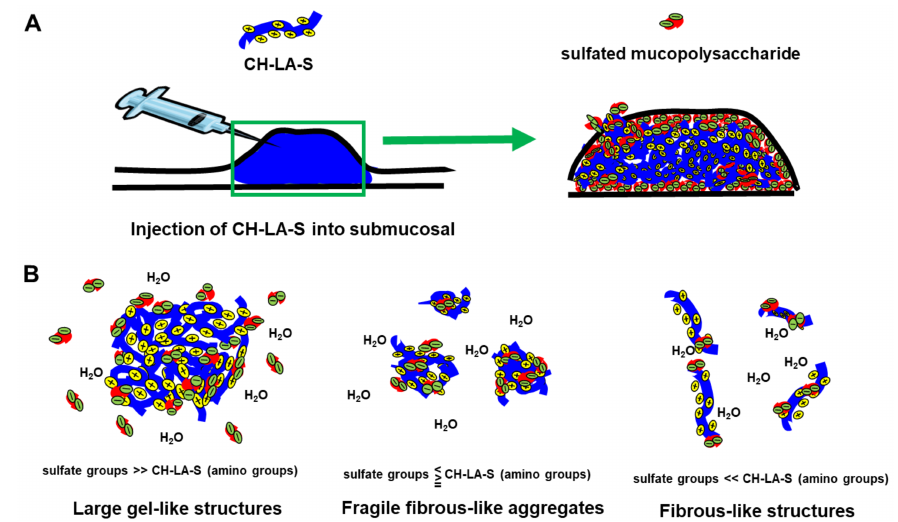
Figure 7. ( A ): Scheme of when CH-LA-S is injected into submucosa. CH-LA-S is adhered to parts in contact with tissues, but the inside of the injected CH-LA-S remains fluid. ( B ): Scheme of different formation patterns due to difference in amount of CH-LA-S and sulfated mucopolysaccharides. Reprinted from [27], Copyright 2017, with permission from